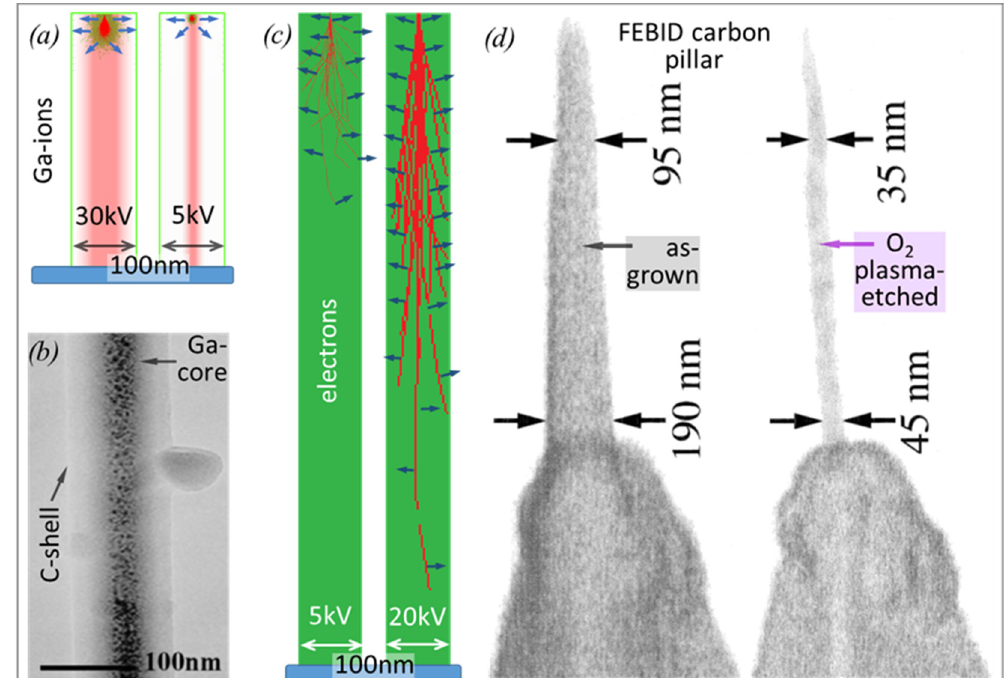
Figure 2. ( a ) SRIM (stopping and ranges of ion in matter) [15] simulation of a zero-diameter gallium ion beam and 100 trajectories (red) with the adjacent collision cascade (green) in a 100 nm wide and 400 nm tall pillar of carbon (density 2 g/cm 3 ) illustrating the inevitable implantation of Ga (shaded red) and its redistribution via the collision cascade for primary energies of 30 kV (left) and 5 kV (right). Blue arrows signify secondary electrons (SEs), leading to deposition events if generated in close proximity to the surface. ( b ) TEM image of a core–shell structure of an as-grown Ga-based, FIBID carbon pillar using phenanthrene. Modified from Matsui et al. [69] . ( c ) CASINO [66] simulation of a zero-diameter electron beam and 20 trajectories (red) in a 100 nm wide and 1 µm tall carbon pillar for primary electron energies of 5 keV (left) and 20 keV (right). The electron trajectories were truncated once they exit the pillar volume for the sake of clarity. Blue arrows again indicate SEs generated along the electron paths. ( d ) SEM side view images of a carbonaceous FEBID pillar deposited from residual vacuum pump oil molecules on an AFM tip before (left) and after oxygen plasma treatment (right). The much narrower core that remains indicates a different chemical bonding, which is closely related to different mechanical properties. Modified from Wendel et al. [68] . Note that ( a ) and ( c ) have the same scale for easy comparison and that the pillar diameters will also depend on the charged particle beam intensity profile (focus), which was omitted for the sake of clarity.